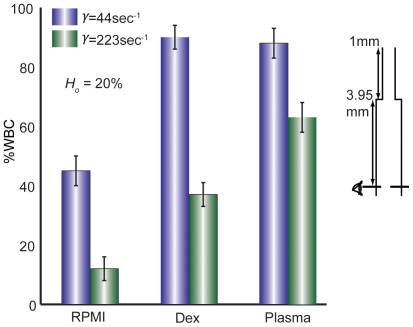
WBC margination is more dramatic at lower shear rates.Blood suspended in RPMI, Dextran 500 or plasma experiences a significant drop in WBC margination as shear rate is increased from 44 sec−1 to 223 sec−1.